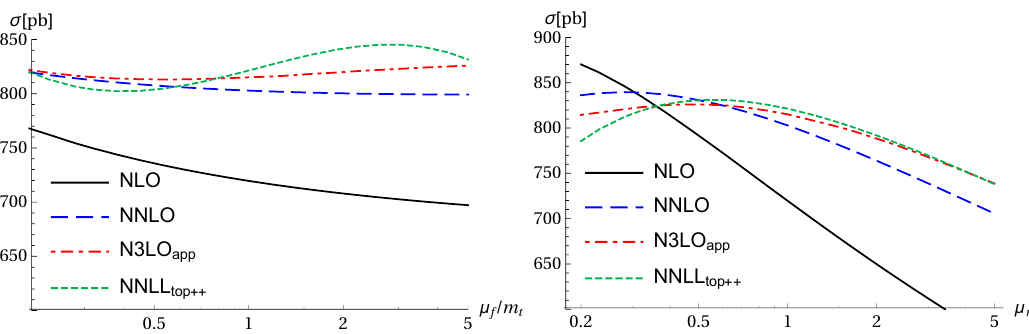
p s = 13 TeV in various approximations. Left: